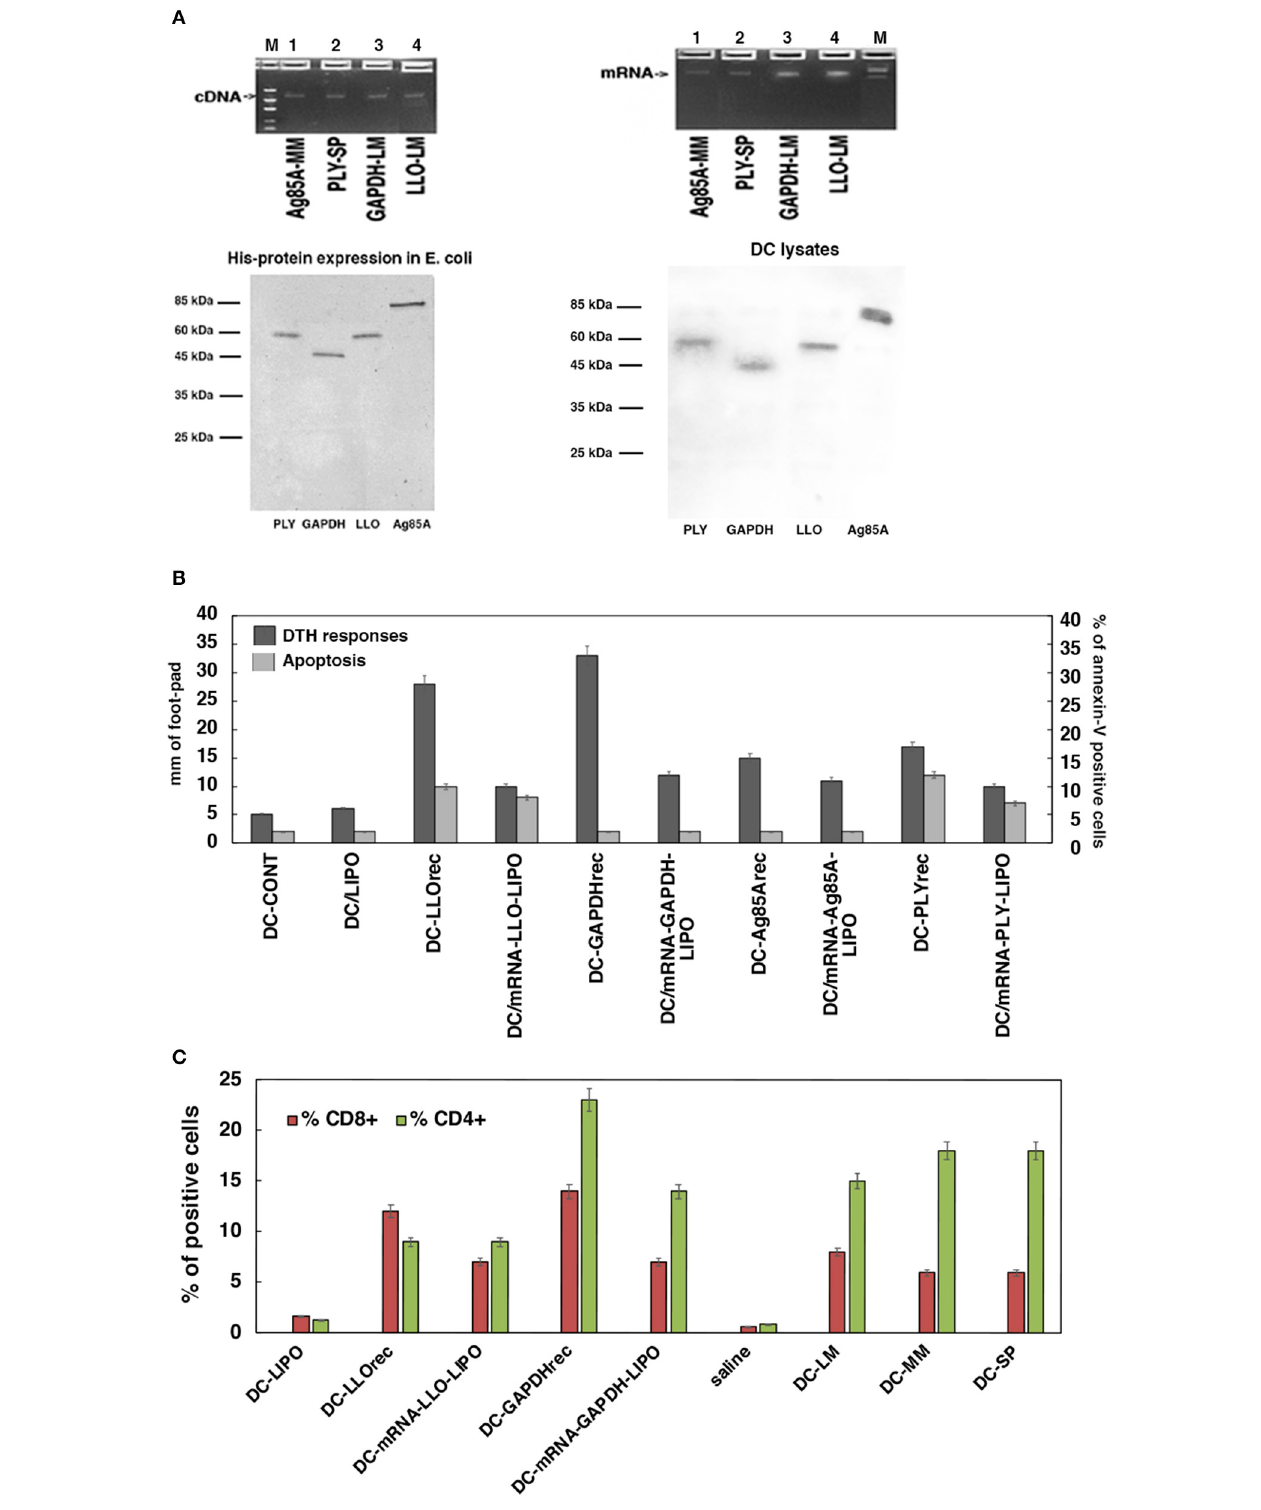
FIGURE 2 | Selection of the antigen forms for the vaccines. (A) Upper geles correspond to preparation of the mRNA antigens from cDNA plasmids encoding for Ag85A antigen of M. marinum (MM), PLY of S. pneumoniae (SP), and GAPDH or LLO of L. monocytogenes (LM) after in vitro transcription. Gels show the linear plasmids (upper left) and mRNA transcripts (upper right). Concentration of the mRNA preparations and qualities are shown in Supplementary Figure 1A . Lower gels